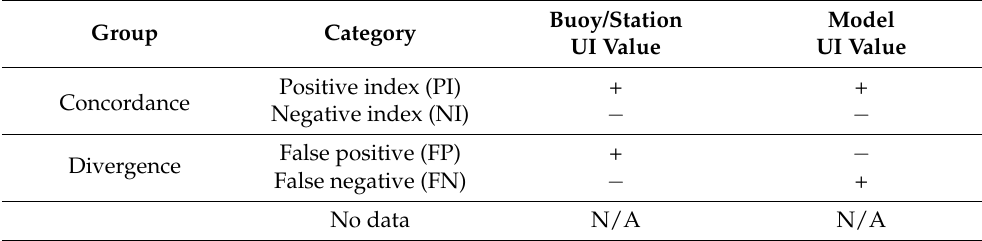
Table 2. Categories for evaluating the comparison between calculated and reference UI.